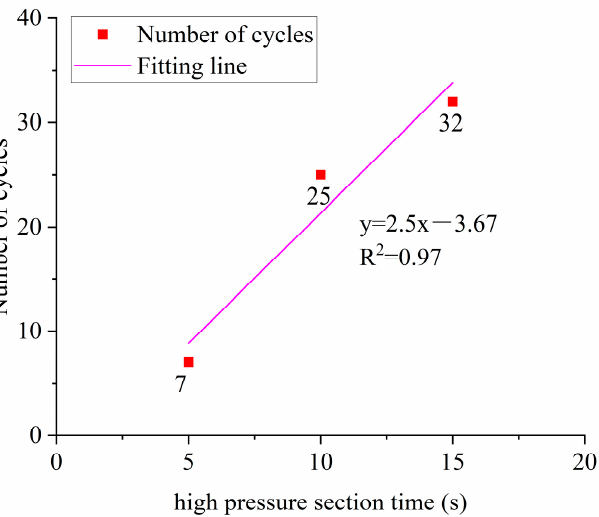
Figure 8. The relationship between high-pressure duration and the cycles required for breakdown.